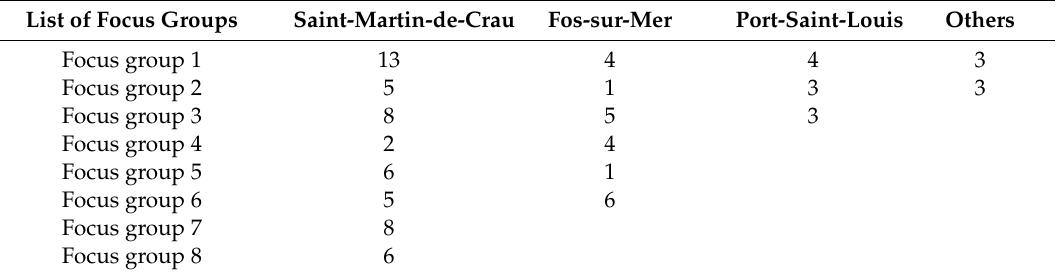
Table 1. Focus group attendance in phase 2 of Fos EPSEAL.